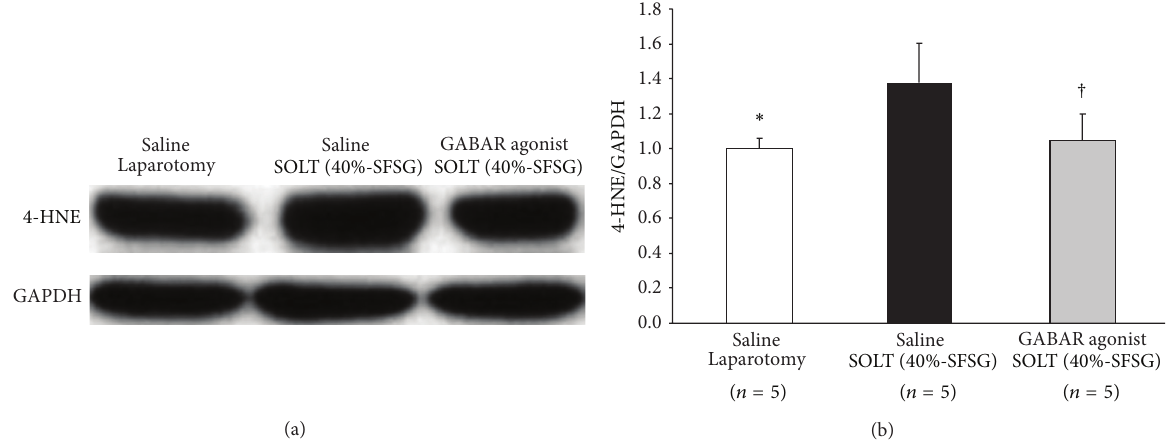
Figure 5: Western blot analysis of 4-HNE. (a) Intensities of 4-HNE and GAPDH. (b) Normalized 4-HNE. There were significant differences between laparotomy and SOLT with saline ( 𝑃 < 0.05 ∗ ) and between SOLT with saline and SOLT with GABAR agonist ( 𝑃 < 0.05 † ). 4-HNE, 4-hydroxynonenal; GABAR, 𝛾 -aminobutyric acid receptor; GAPDH, glyceraldehyde-3-phosphate dehydrogenase; SFSG, small-for-size graft; and SOLT, split orthotopic liver